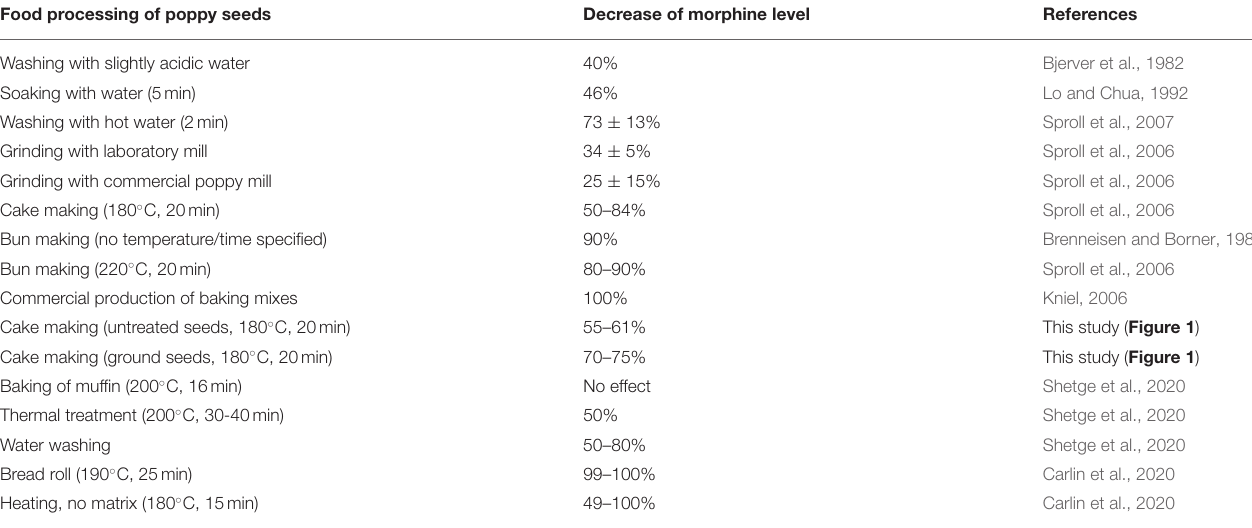
FIGURE 1 | Morphine reduction during poppy cake baking with ground or unground poppy seed [results of full factorial design with 2 morphine levels and two treatments at two levels (with or without grinding and/or baking at 180 ◦ C for 20min), ANOVA p < 0.0001, method according to Sproll et al. (2006)]. (A) Comparison between raw and baked poppy cake for two different seeds types. (B) Influence of baking and grinding for seed type with high morphine content. Both baking and grinding lead to highly significant reduction of morphine. The influence of baking is ∼ 2-times the one of grinding. If both treatments are applied, the reduction is about 70%. TABLE 1 | Changes in morphine content of poppy seed foods during processing according to literature data. Food processing of poppy